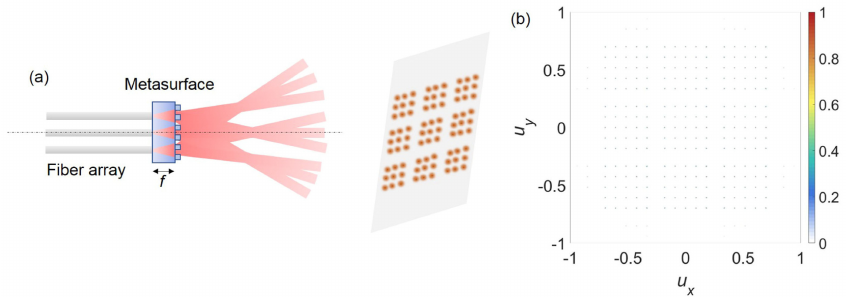
Figure 7. Metasurface collimating splitter based on a fiber array. ( a ) Schematic for the large-scale spot array generation by the metasurface collimating splitter based on a fiber array, combining both the effect of Fourier transformation and the diffraction of the Dammann grating component. ( b ) Far-field intensity of the metasurface collimating splitter based on a 5 × 5 fiber array using the angular spectrum propagation